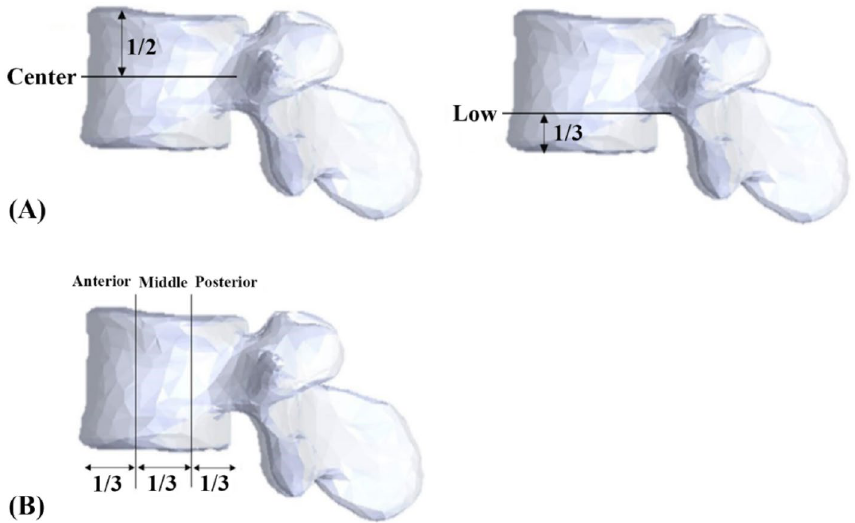
Figure 8. Designation of screw insertion positions. ( A ) The central position is defined as the middle part of the superior and inferior endplates in the lateral plane of the vertebra, while the lower position is the lower third between the superior and inferior endplates. ( B ) The anterior position is defined as the middle of the anterior third of the vertebral body, the middle position is the middle of the middle third and posterior position is the middle of the posterior